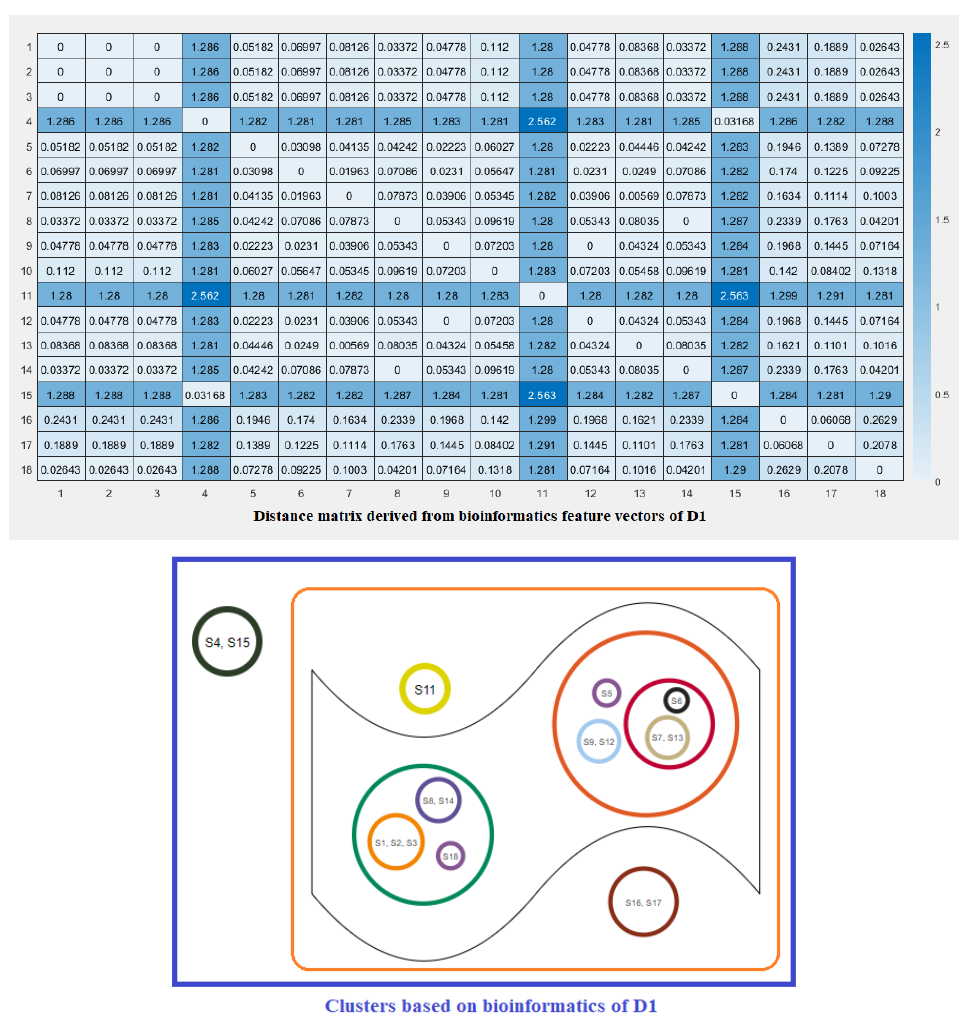
Figure 7. Distance matrix based on the bioinformatics feature vectors of D1 of ACE2 across eighteen eighteen species and associated clusters.